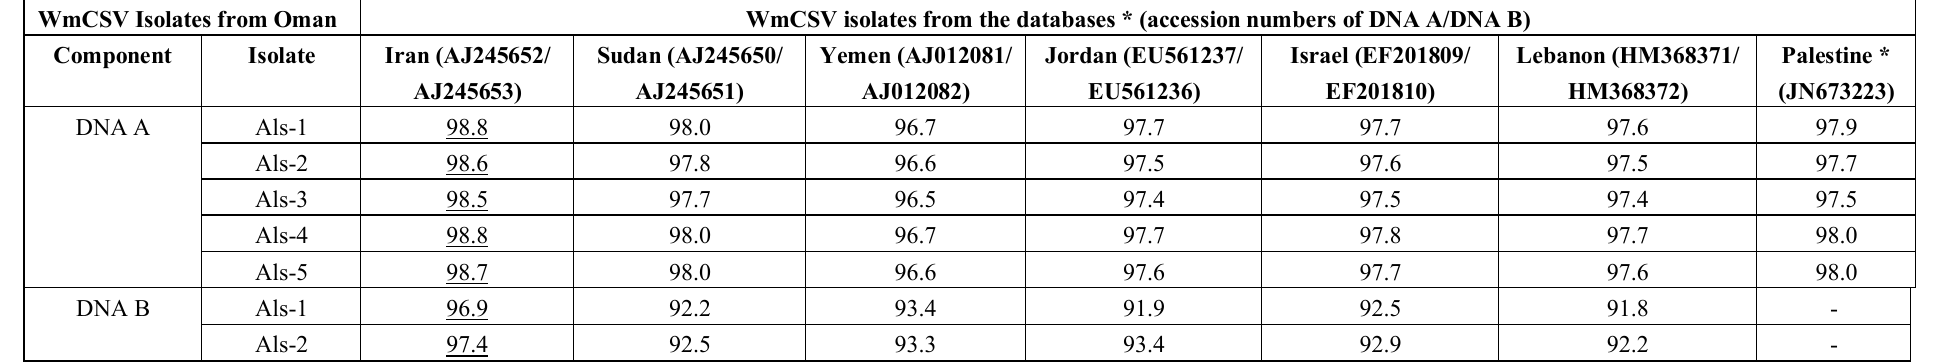
Table 2. Percentage nucleotide sequence identities of WmCSV clones isolated from Oman with WmCSV isolate sequences available in the databases. WmCSV Isolates from Oman